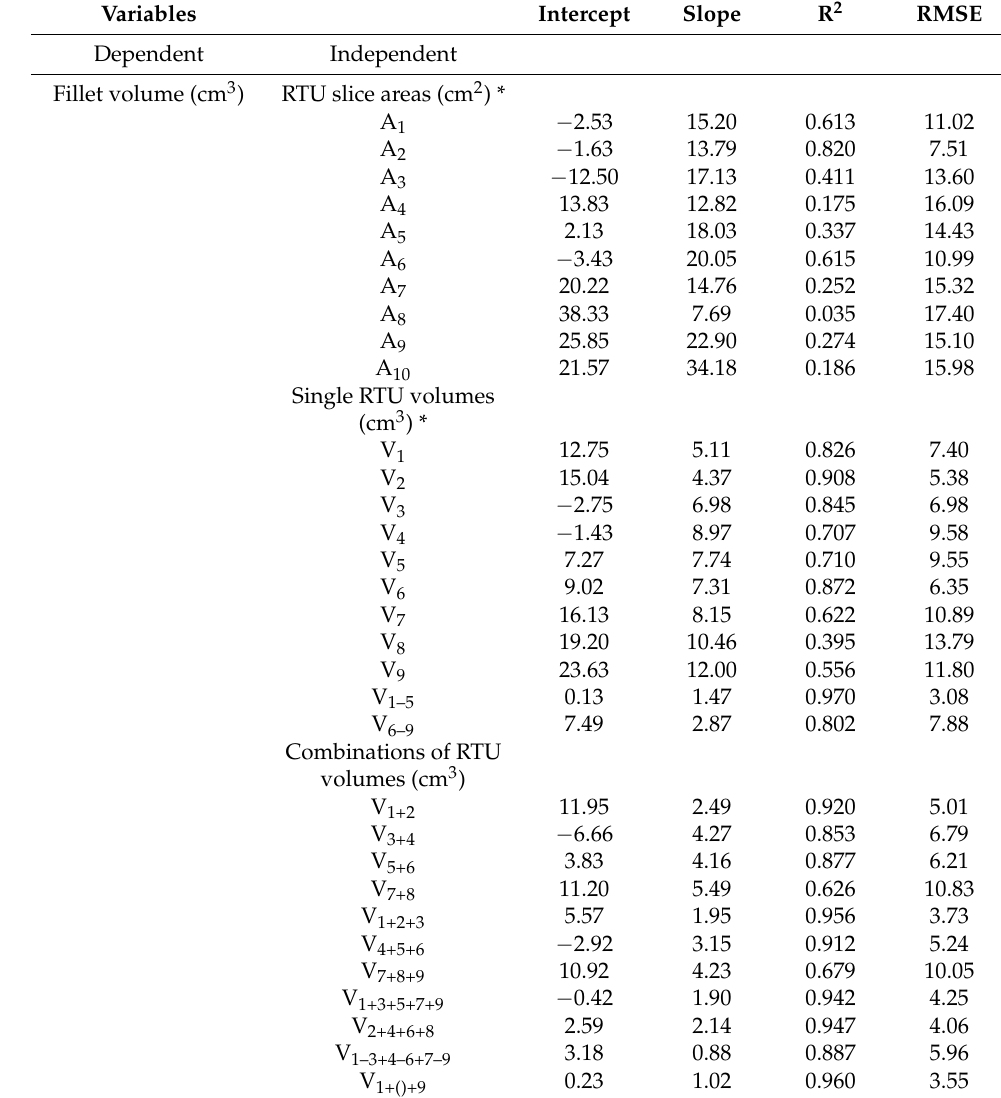
Table 2. Simple linear regressions between the right dorsal fillet volume and real-time ultrasonic (RTU) traits for the right dorsal fillet (n =